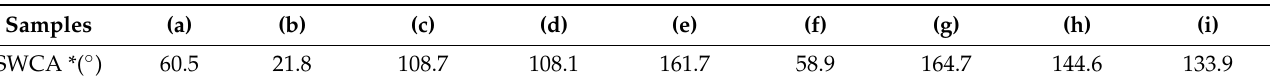
Table 2. Static water contact angles for (a) untreated aluminum alloy, (b) NaOH-etched alu- minum alloy at 25 ◦ C after HCl washing, (c) HCl-washed aluminum alloy after Na 2 CO 3 etching, (d) Na 2 CO 3 -etched aluminum alloy at 25 ◦ C, (e) stearic-acid-treated aluminum alloy after Na 2 CO 3 etching, (f) NaOH-etched aluminum alloy at 90 ◦ C, (g) stearic-acid-treated aluminum alloy after NaOH etching at 90 ◦ C, (h) stearic-acid-treated sample after Na 2 CO 3 etching after abrasion test